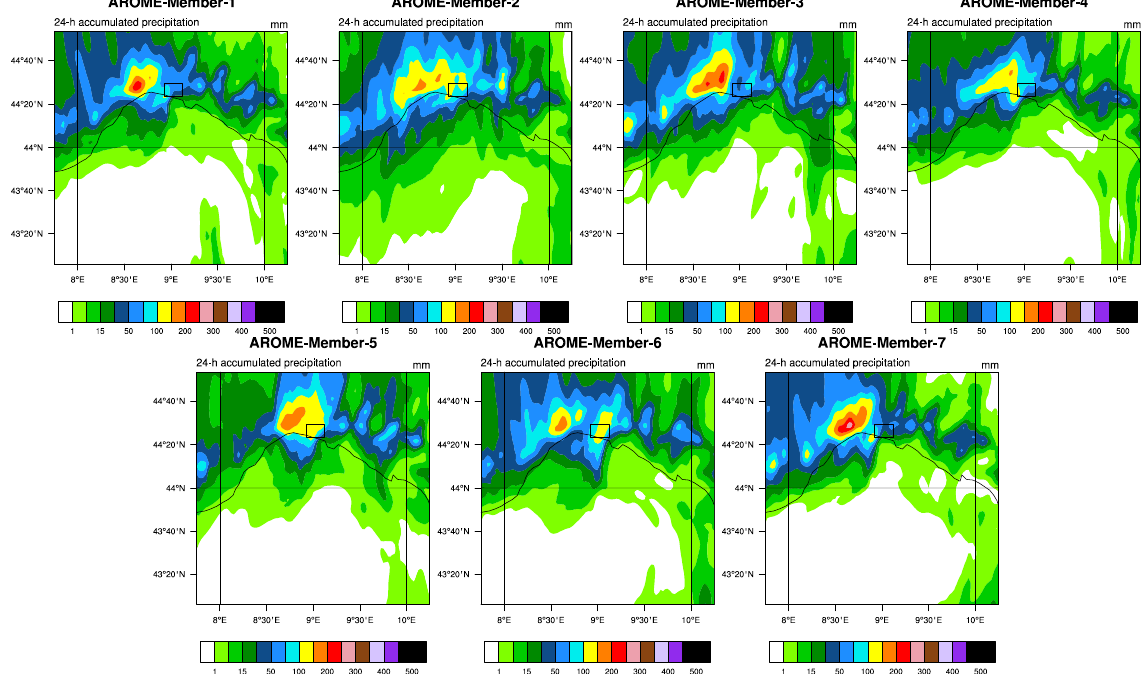
Figure 8. The 24h simulated rainfall amounts (in mm) of the 7 members of the AROME ensemble between 00:00UTC on 4 November and 00:00UTC on 5 November.